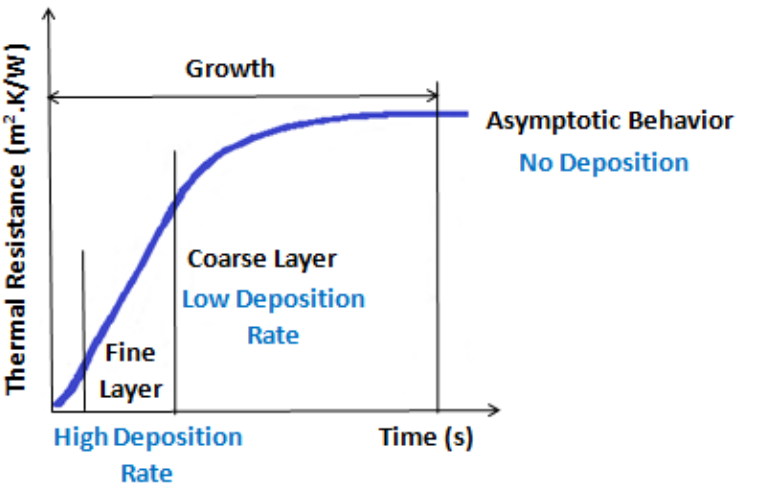
Figure 4. Thermal resistance vs. time and main stages of the particulate fouling. Adapted from [49].